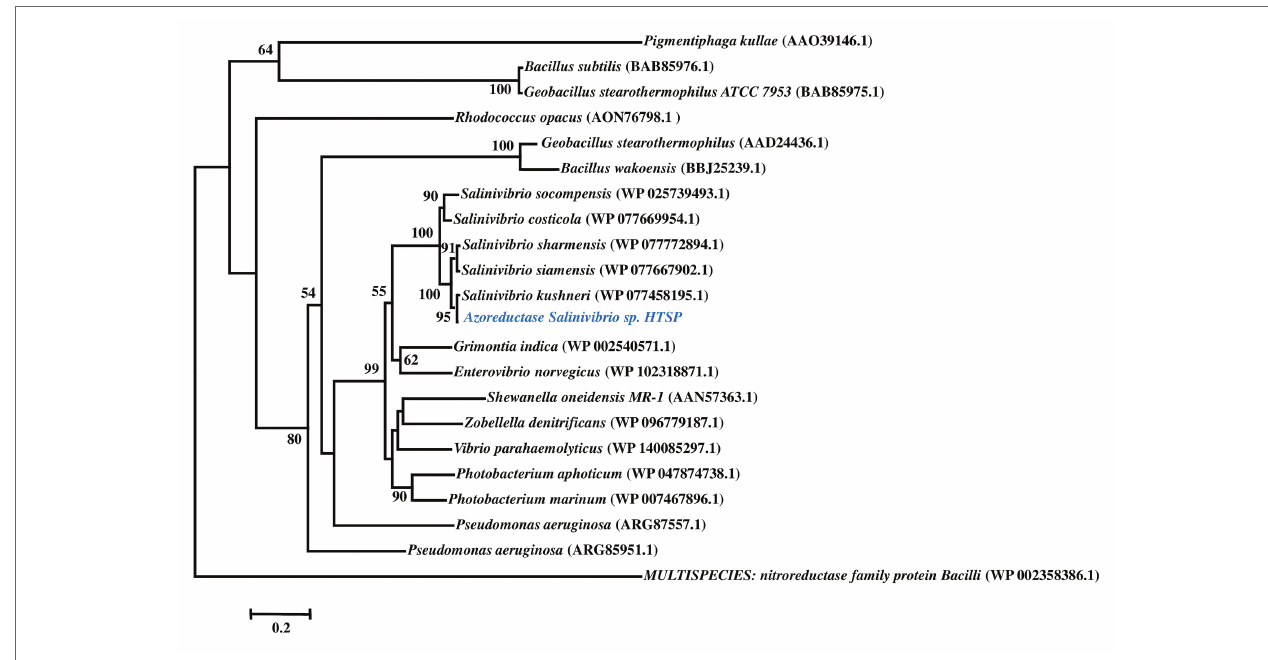
FIGURE 1 | Phylogenetic tree of azoreductase based on amino acid sequences. Amino acid sequences for nitroreductase is used as an